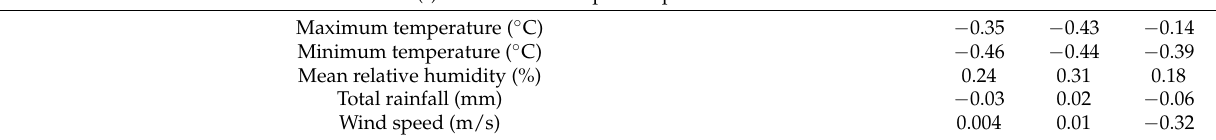
Mean no. of Pea Aphid per 20 Twigs in the Tested Lentil